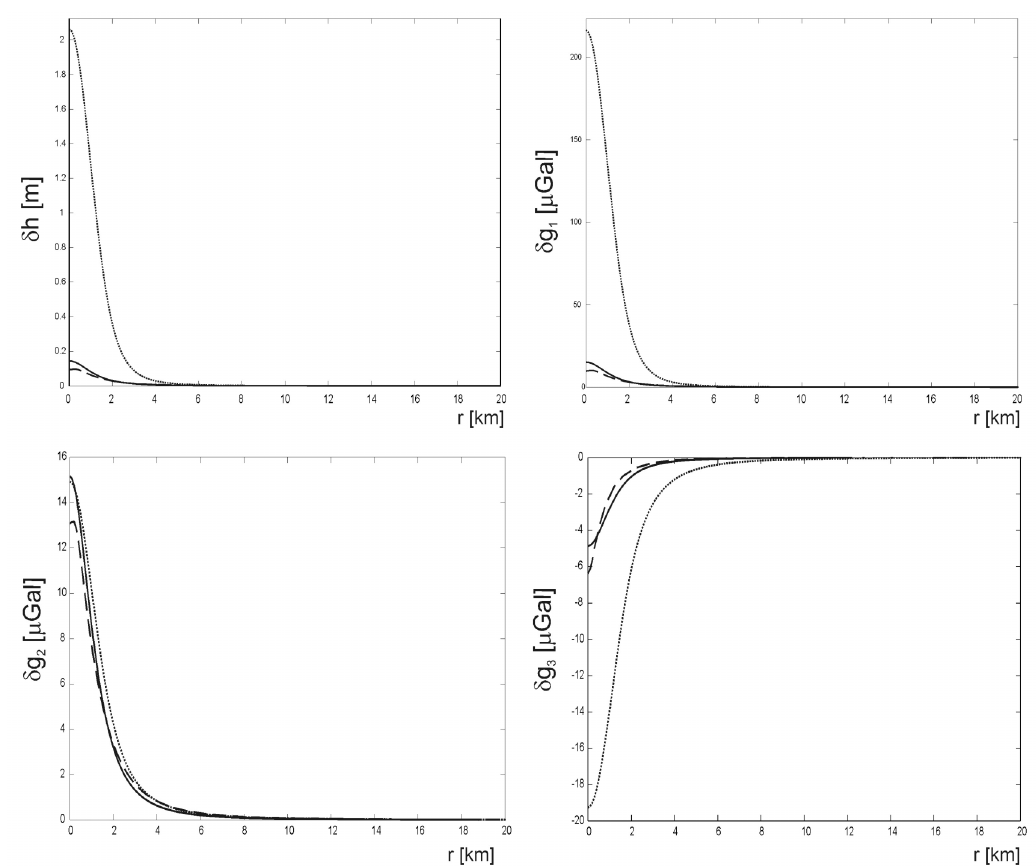
Fig. 7. Elevation and gravity changes for three source shapes: the SP source (solid line), the VPS source (dashed line) and the HPS source (dotten line). The numerical model assumes an homogeneous elastic half space. The geometric parameters were chosen for all the sources in a way to assure the same volume. The source depth was fixed to 1.5